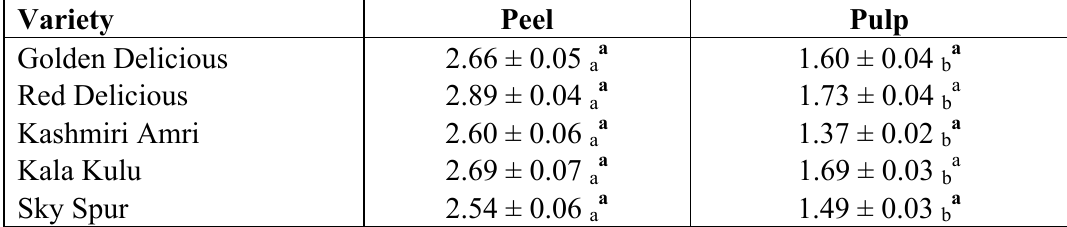
Sky Spur 1.49 ± 0.03 Data are mean ± SD ( n = 3 × 3, P < 0.05); Different superscript letters within the same column indicate significant differences ( P < 0.05) among cultivars; Different subscript letters within the same row indicate significant differences ( P < 0.05) between peel and